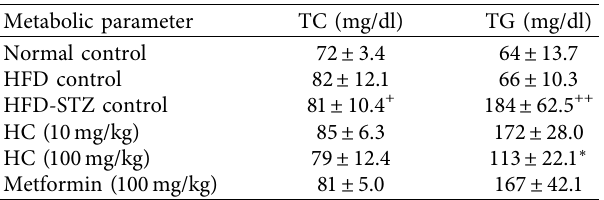
Table 4: Total cholesterol (TC) and total triglyceride (TG) in each